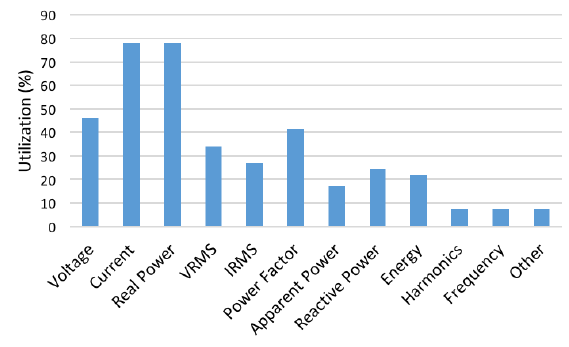
Figure 7. Parameters used by the